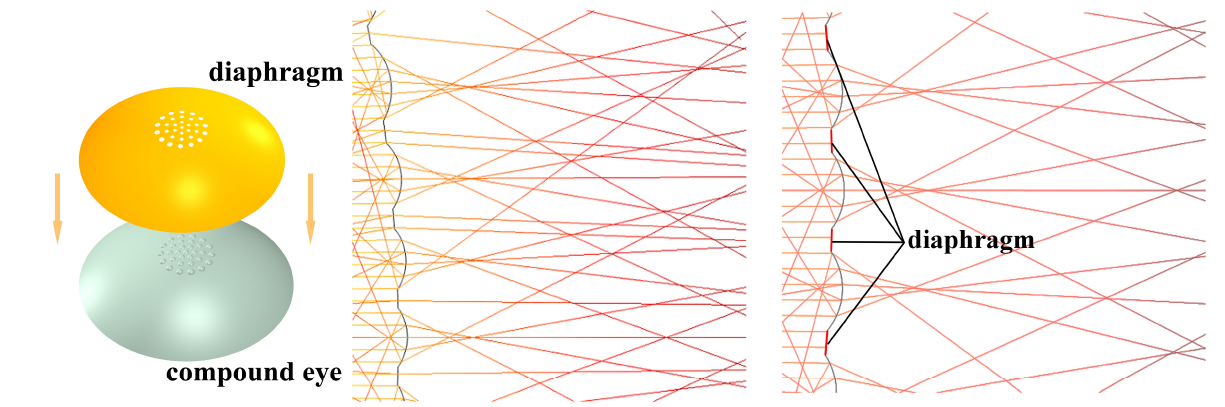
Figure 9. Comparison of light entering a compound eye lens with a diaphragm and a compound eye lens without a diaphragm.